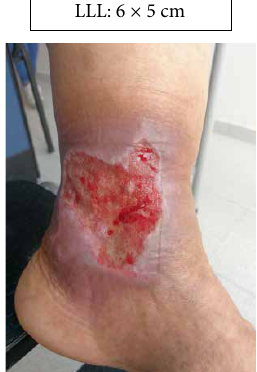
Figure 21: Week 6. Lower left limb.